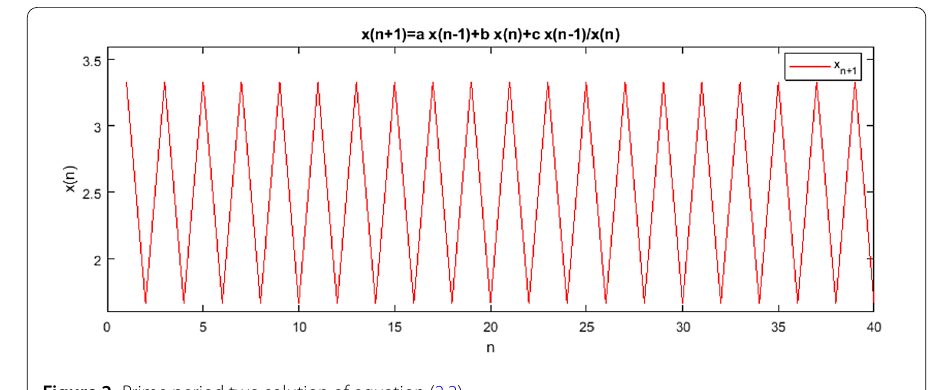
Figure 2 Prime period two solution of equation